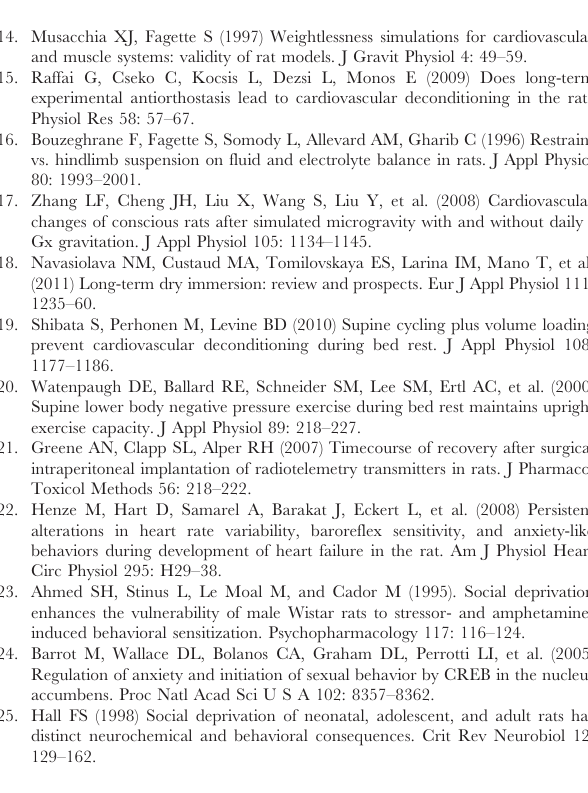
Figure 5. Heart rate and blood pressure during treadmill running. Heart rate (left) and mean arterial pressure (right) during a treadmill running test before ( PRE ) and after ( POST ) 14-days of control ( A ), isolation-control ( B ), isolation ( C ), attachment ( D ), and unloading ( E ). Cage: in experimental cage. TM1: in the treadmill cage, at rest, before exercise. EX: during treadmill running. TM2: in the treadmill cage, at rest, after exercise. Data are given as a mean 6 SEM. *and # - P , 0.05 versus respective TM1